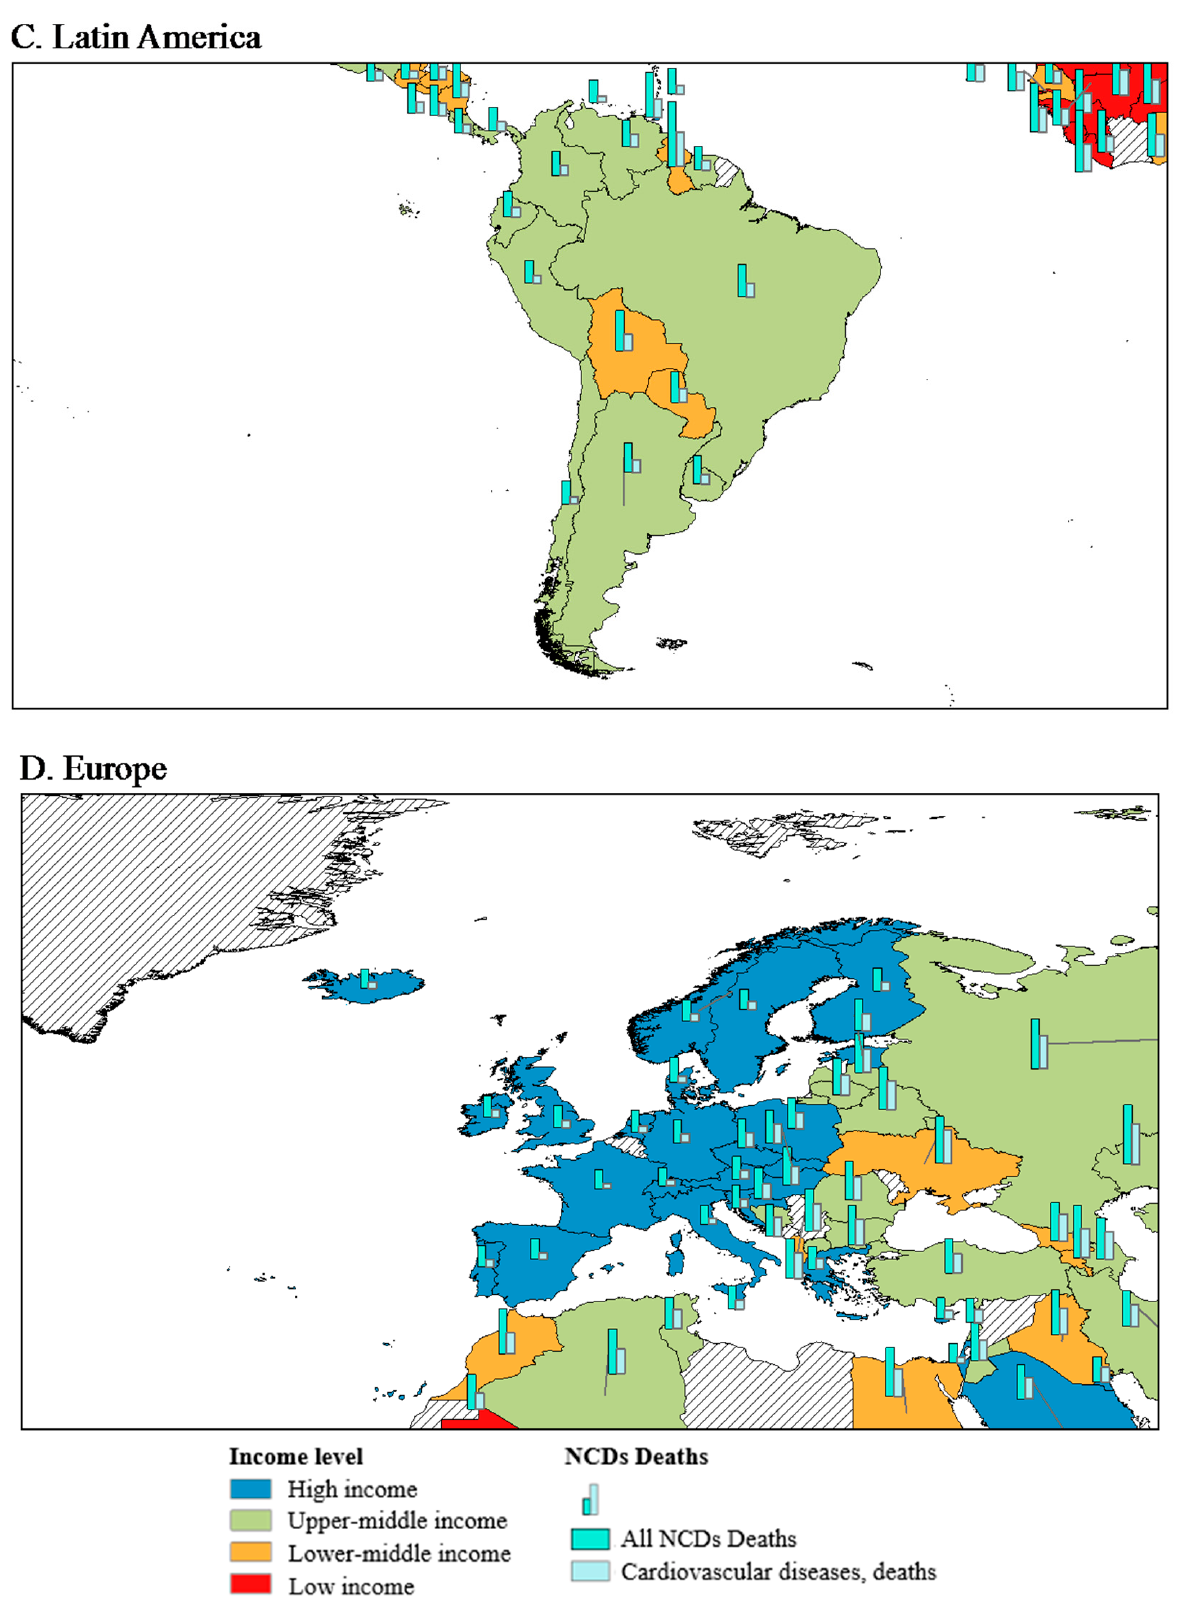
Figure 3. Distribution of income level and NCD deaths (all NCDs and CVDs, per 100,000). Nutrition composition, food supply, and health-related behaviors according to the income level of the countries are shown in Table 2. We see increasing trends in the intake of total energy (HICs: 3355 ± 287 kcal vs. LICs: 2274 ± 210 kcal), fat (HICs: 35.4 ± 5.7% vs. LICs: 16.7 ± 4.2%), and protein (HICs: 12.1 ± 0.7% vs. LICs: 10.5 ± 1.3%) with increasing income level ( p < 0.001). In contrast, there is evidence of increasing carbohydrate intake (HICs: 52.5 ± 5.8% vs. LICs: 72.8 ± 4.0%) with decreasing income level ( p for trend < 0.05). As in the region, carbohydrate intake in Africa was higher, by the same in LLIMCs in Asia, Latin America, and Europe, whereas fat and protein intake were lower than those in HICs and upper-middle-income countries (Figure 4). On the contrary, HICs in Europe and Asia had a higher intake of protein and fat, whereas they had a lower intake of carbohydrates.